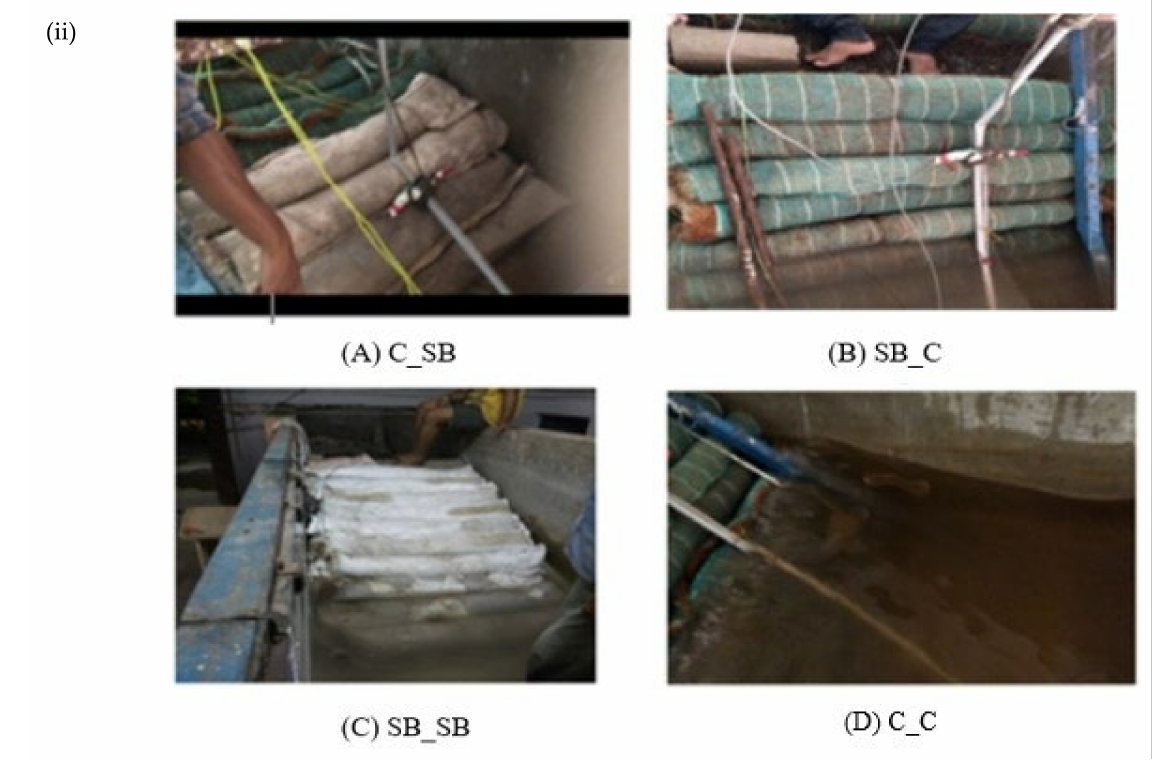
Figure 3. Experimental arrangements.